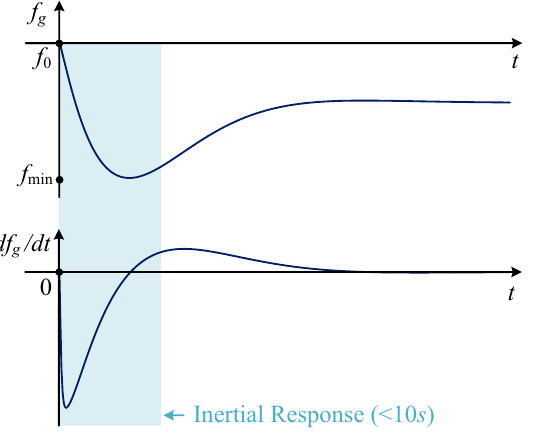
Figure 3. Typical power system frequency response after a disturbance (e.g., a load step change).